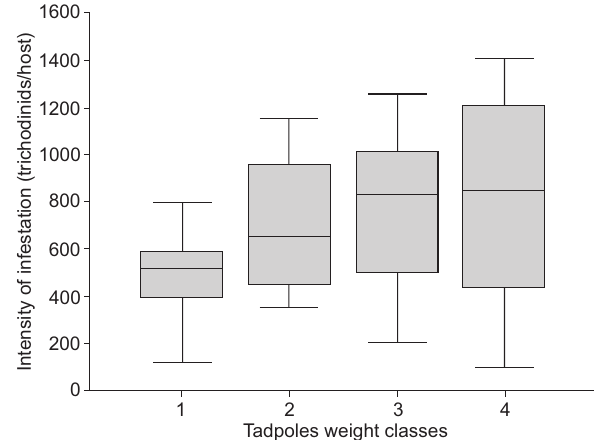
tadpoles.Figure 6. Infestation intensity by Trichodina heterodentata on Rhinella pombali tadpoles weight classes. The boxes represent the distribution of infestation intensity within the classes. Host weight